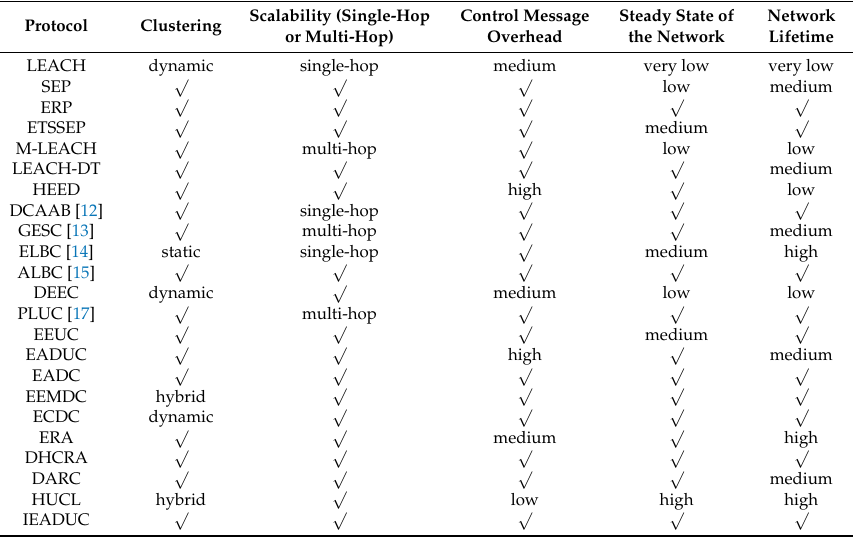
Table 1. The metrics and performance of the